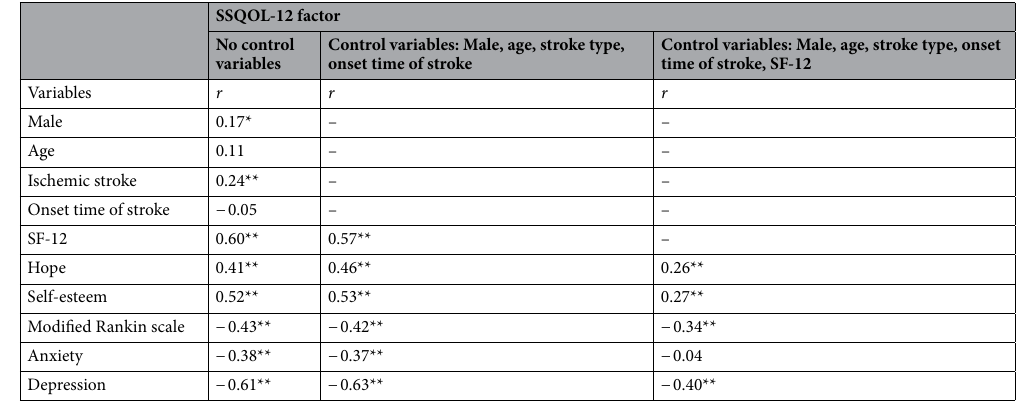
Table 5. Correlations and partial correlations between the SSQOL-12 factor and demographic covariates, SF-12, coping variables, and distress variables at baseline. N = 178–183; * p < .05; ** p < .01; SSQOL = stroke- specific quality of life; SF-12 = Short Form Health